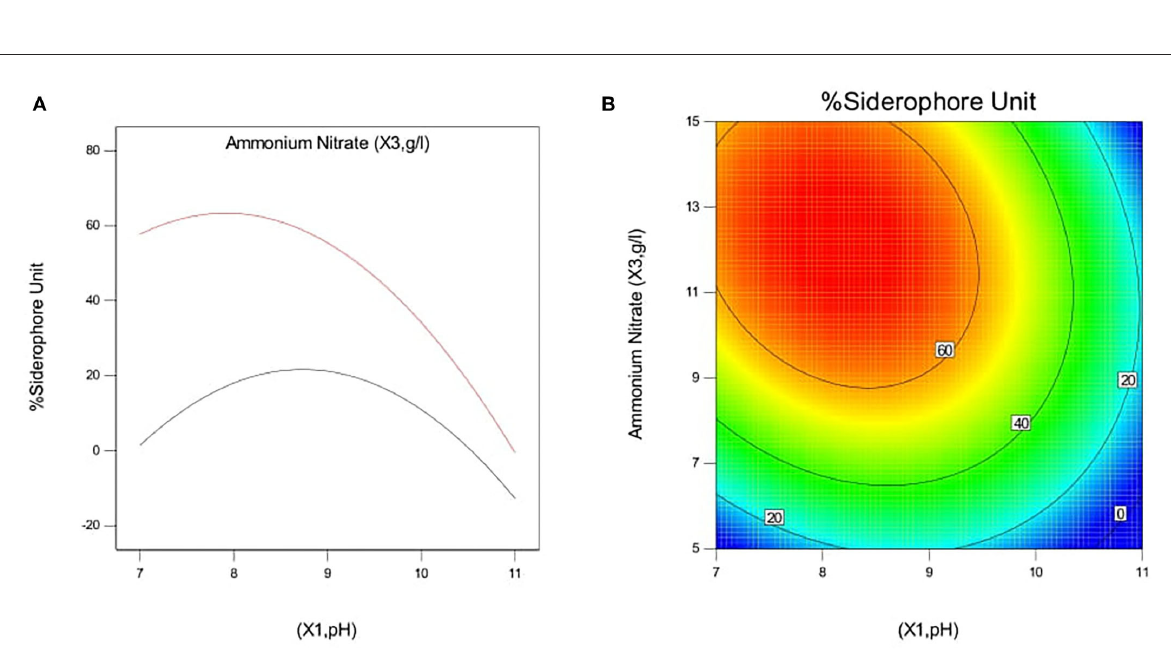
Siderophore biosynthesis in P. monteilii was not supported by any of the four carbon sources tested (sucrose, glucose, starch, and mannitol),as the yield was less than 20% SU in